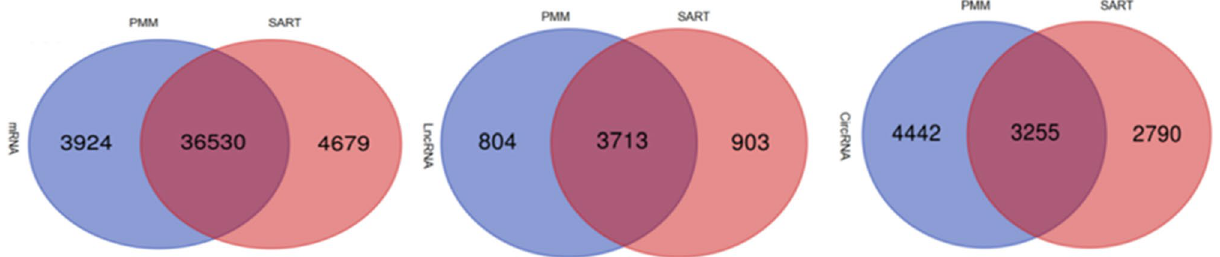
Figure 2. Venn diagrams represent all the numbers of expressed mRNAs, lncRNAs, and circRNAs between PMM and